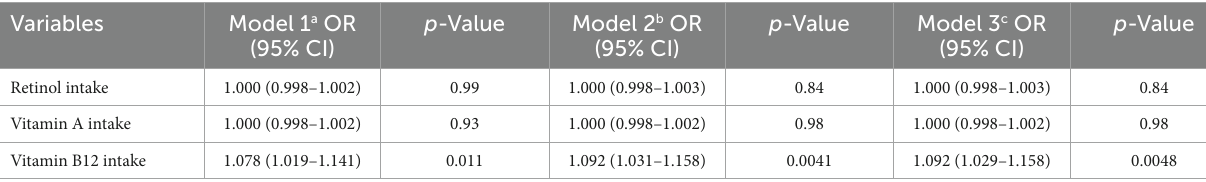
TABLE 2 Association between intake of retinol, vitamin A, vitamin B12 and glaucoma.